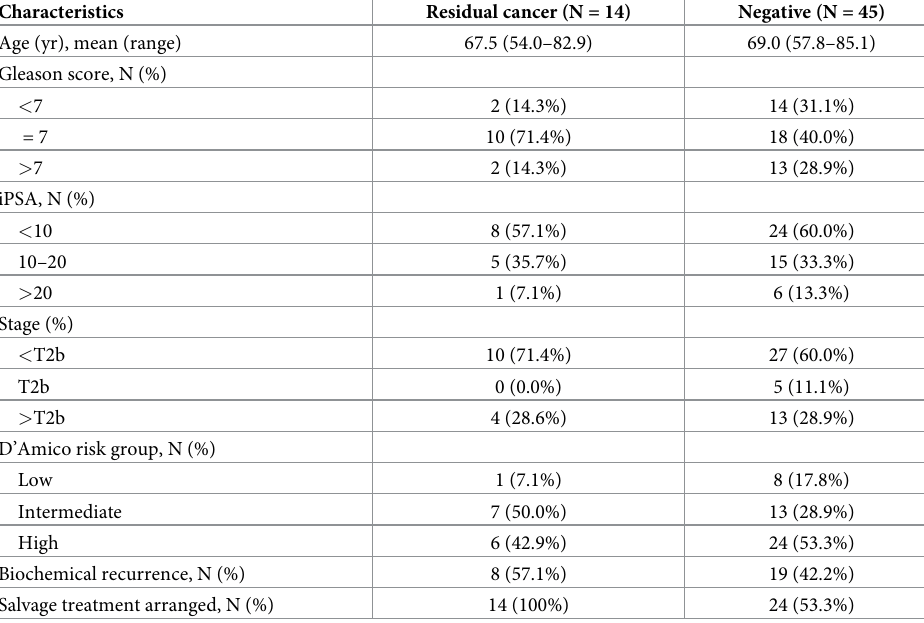
Table 5. Characteristics of patients receiving post-HIFU prostate